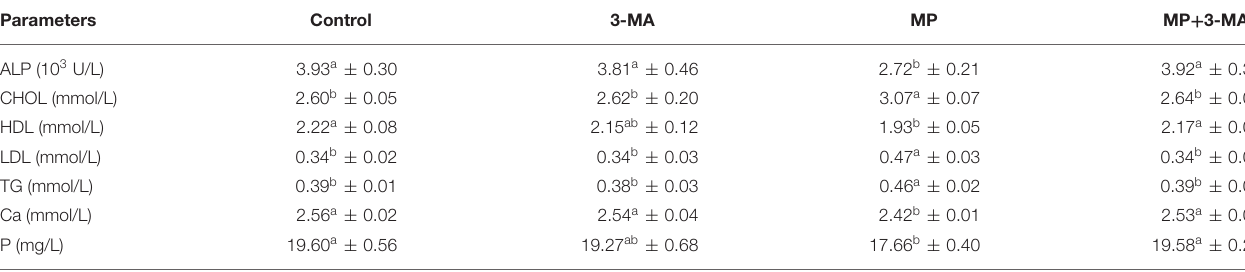
TABLE 6 | Laboratory biochemical indicators. Parameters